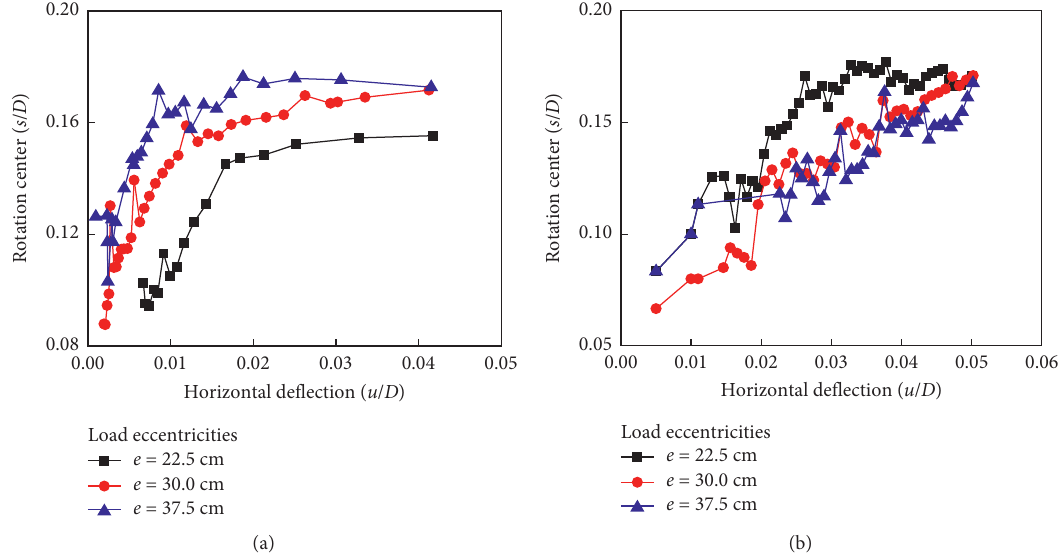
Figure 11: Rotation center distribution in the loading direction. (a) For the CHFRF no. II-D. (b) For the circular gravity-based